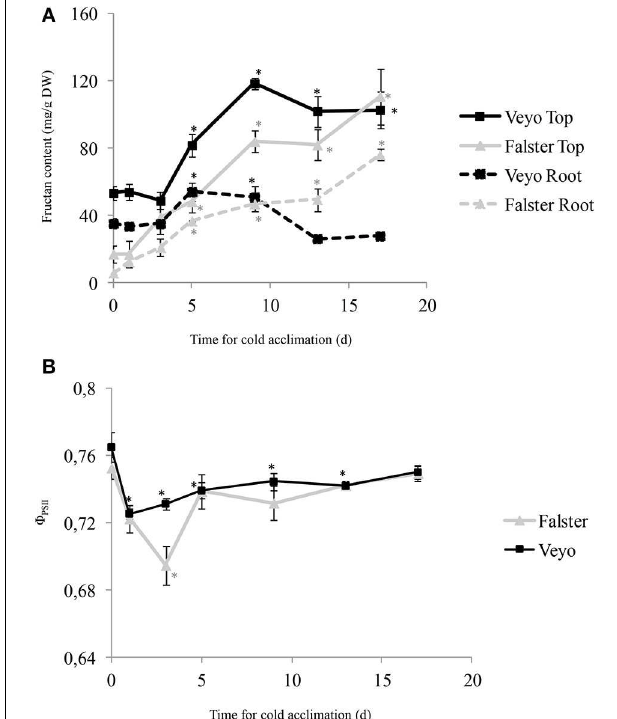
FIGURE 1 | Fructan accumulation in the green tissues (top) and roots, and the changes in quantum yield of photosystem II ( 8 PSII ) of leaves in perennial ryegrass ( Lolium perenne L.) variety “Veyo” and ecotype “Falster” during cold acclimation. (A) Changes in fructan content (mg/g DW) in top and roots of “Veyo” and “Falster.” (B) Changes in 8 PSII in the leaves of “Veyo” and “Falster.” Plants were at 20 ◦ C on d 0 and at 7 ◦ C on d 1–17. Data represent the mean ± SE, obtained from three biological replicates of the analysis. The experiments were repeated twice. Asterisks indicate significant differences ( P < 0 . 05 ) from d